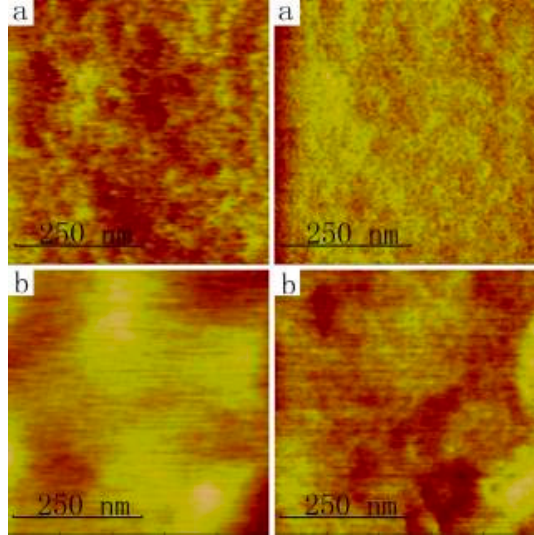
Figure 12. AFM images showing height ( left ) and phase ( right ) maps of ( a ) PU-Si0 and ( b ) PU-Si17 after immersion in seawater.